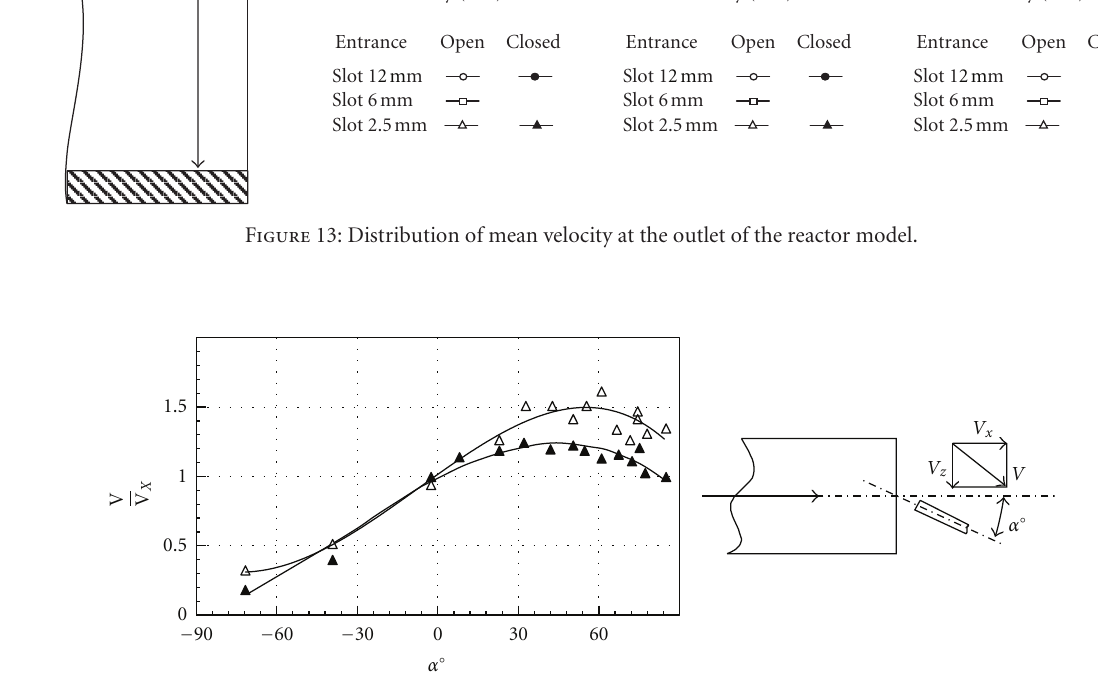
Figure 14: Measurement of twist angle of the annular jet (notation as in Figure 13).